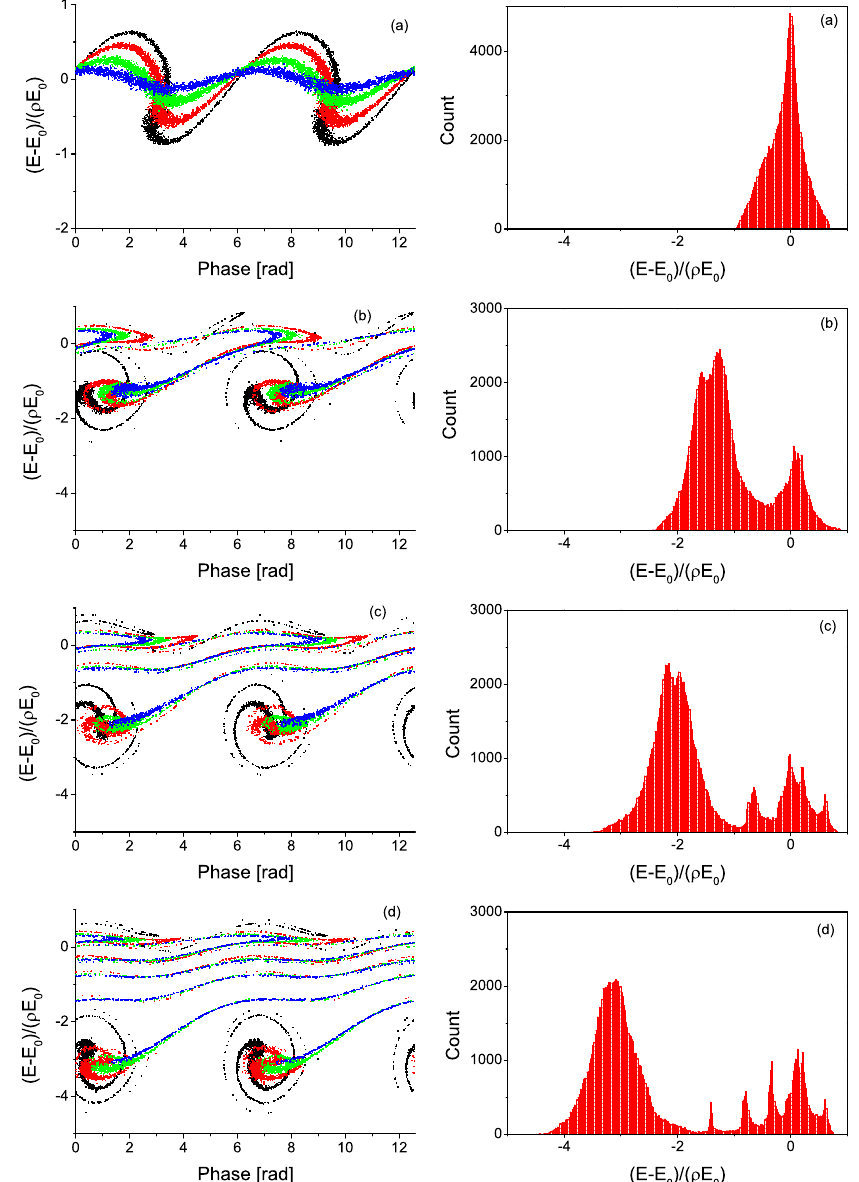
FIG. 9. Phase space distribution of electrons (left column) and population of electrons in energy (right column) at different stages of the trapping process. Color codes correspond to different locations of the particles in the beam (black — core of the beam; blue — edge of the beam). Here diffraction parameter is B ¼ 10 . Plots labeled by (a), (b), (c), and (d) correspond to ð z − z 5.3, respectively (see Fig.